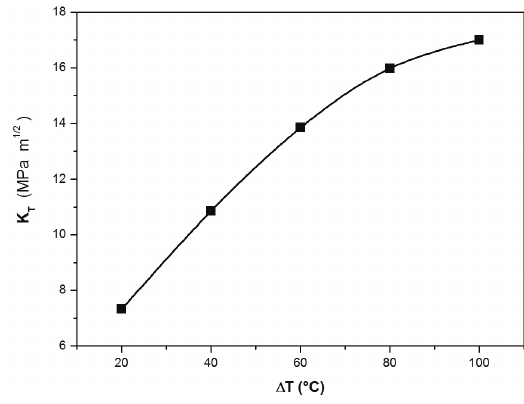
Figure 9. Thermal SIF vs